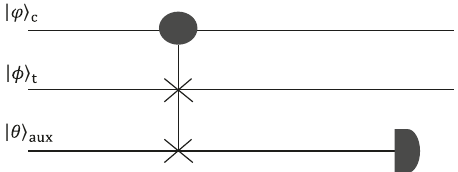
Fig. 2 Controlled measurement. It is performed by a controlled- swap operation, also known as Fredkin gate 63,64 , followed by the measurement of the auxiliary qubit. The auxiliary state has to be suitably prepared depending on the measurement basis and the target state, in order to guarantee that the weights of the fi nal superposition do not